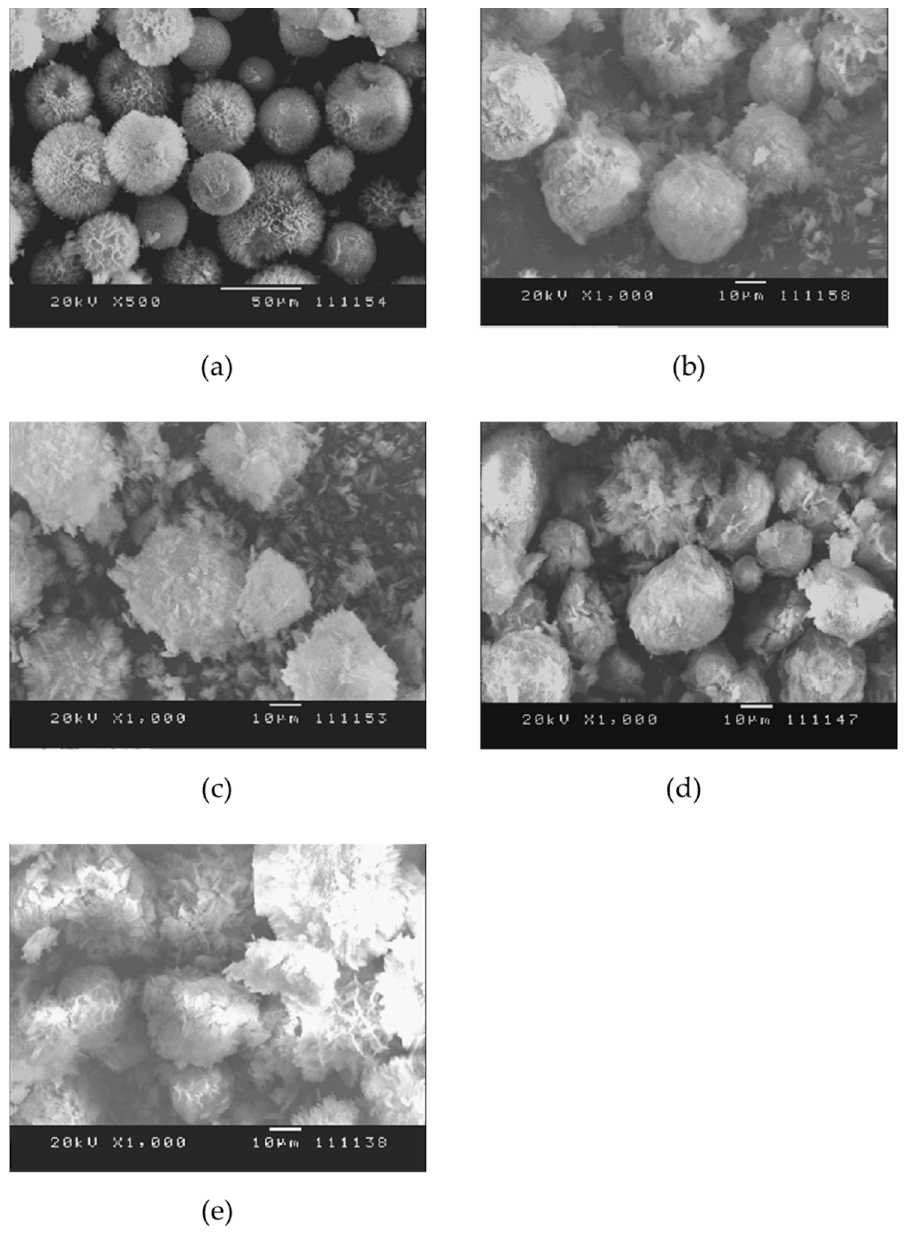
Figure 6 . The surface morphology of the HAp–gelatin porous composite microspheres after drug